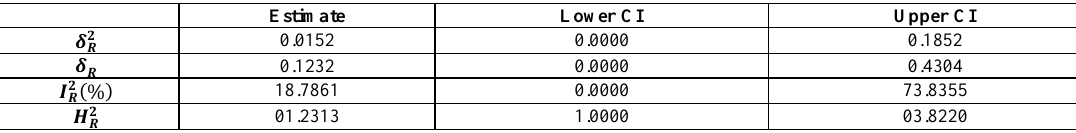
Table 9. Estimates for heterogeneity and variability for random effects